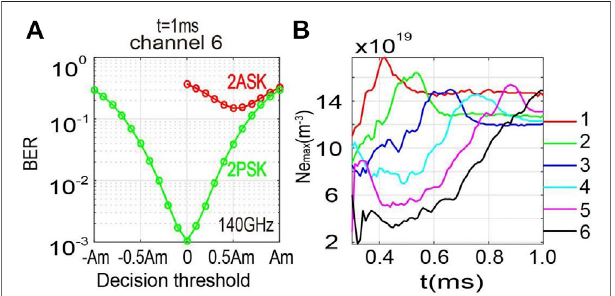
FIGURE 5 | (A) The BER of the EHF signals at different decision thresholds in the side channel 6 of the plasma sheath of sharp-coned reentry vehicle at a speci fi c time ( t = 1 ms), where Am represents the amplitude of the signal; (B) The time-varying curves of the maximum electron density of the side channels (1 –